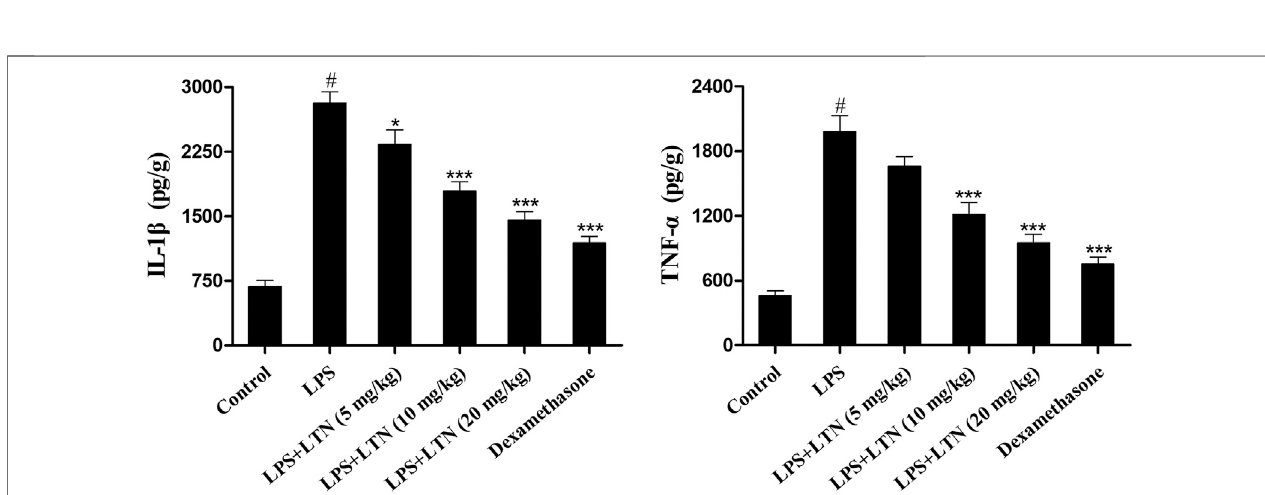
FIGURE 3 | Lentinan inhibited the secretion of proin fl ammatory factors. The expression of TNF- α and IL-1 β in LPS-stimulated mouse mastitis was detected using ELISAkits.Alldataarerepresentedasthemean ± S.E.M.ofthreereplicates.* p < 0.05vstheLPSgroup.** p < 0.01comparedwiththeLPSgroup.*** p < 0.01compared with the LPS